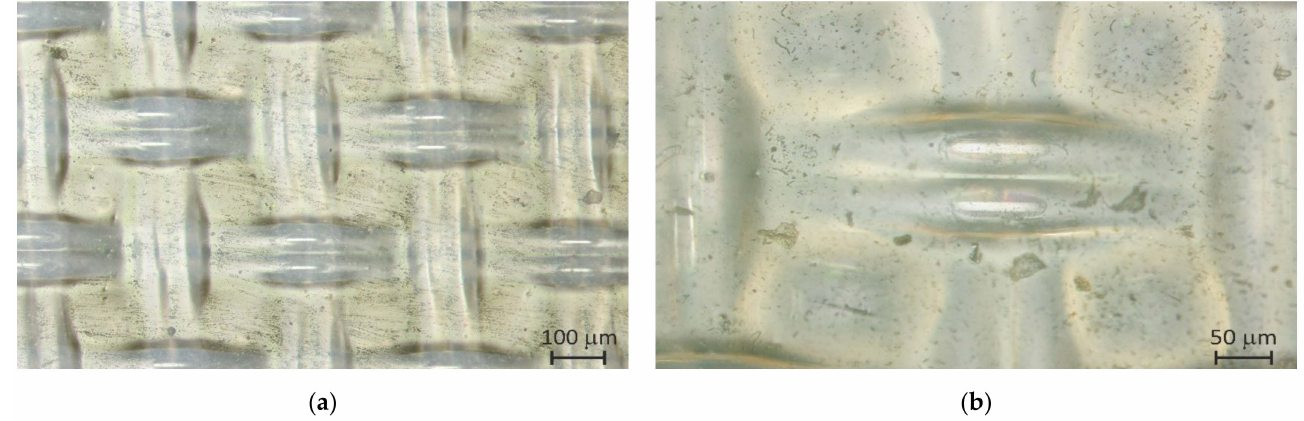
Figure 3. Optic images of the rougher surface of the pristine CJMA-7 membrane taken at different magnification: ( a ) 10 × and ( b ) 20 × .